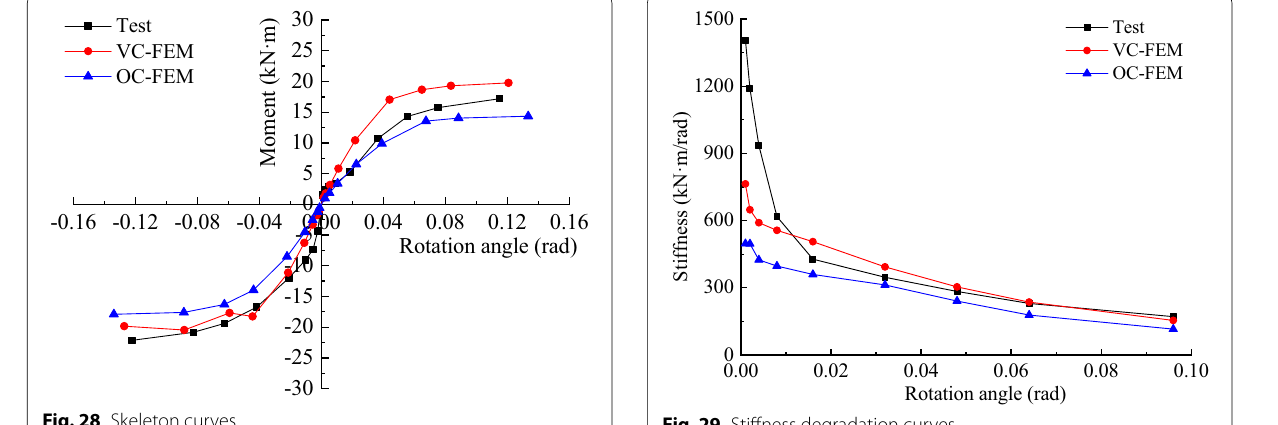
Table 5 Comparisons of yielding moment, ultimate moment and bending stiffness between FEM and test